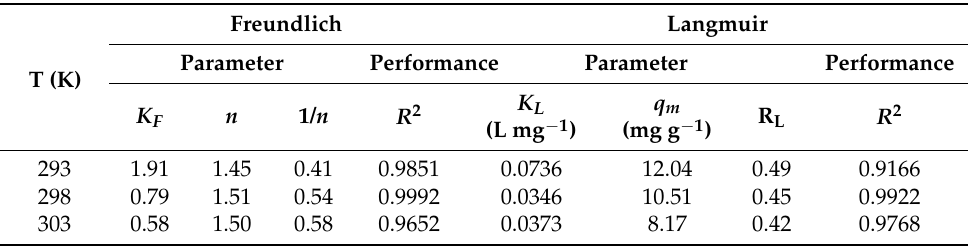
Table 4. The values of isotherm parameters for ammonium adsorption on ox-xGnP at different temperatures.